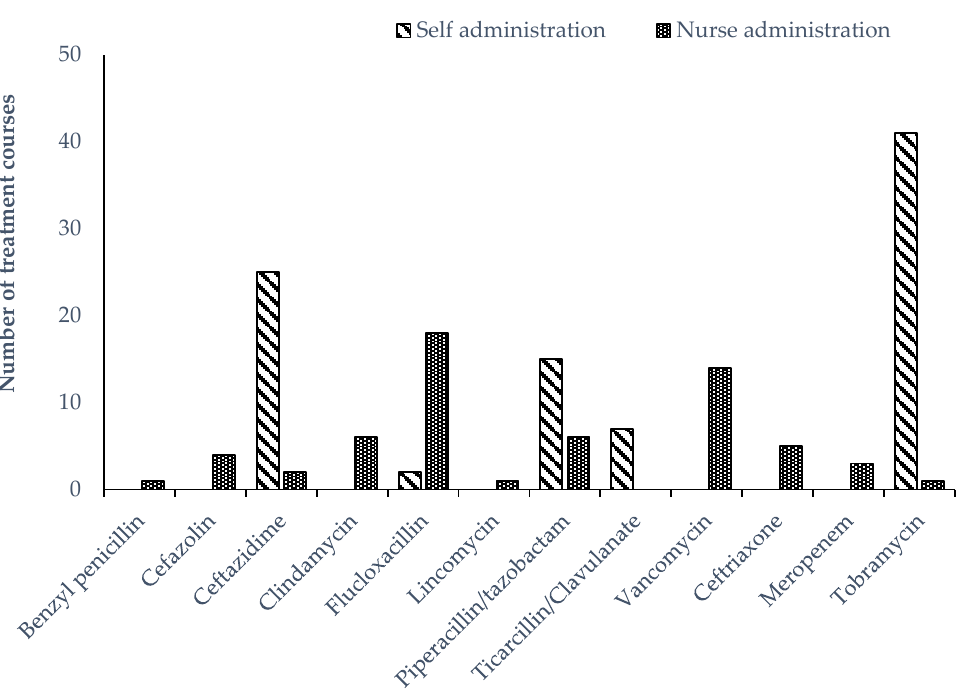
Figure 2. Parenteral antimicrobial therapy prescribed for administration to children receiving OPAT in the home, stratified by nurse or self-administration.